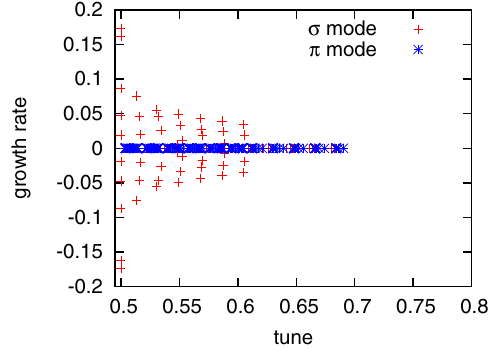
FIG. 13. Growth rate for each eigenmode as a function of the ¼ 0 . 54 in FCCee-Z. The red eigenmode tune for a bare tune ν x and blue points in the plot represent the σ and π modes, respectively.